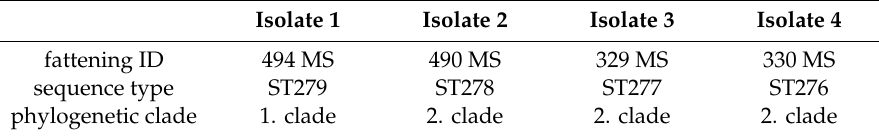
Table 1. Summary of characteristics of ocular C. suis isolates